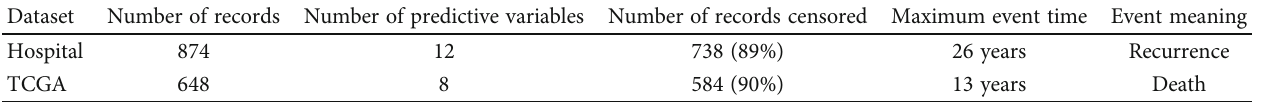
Table 2: Summary datasets.